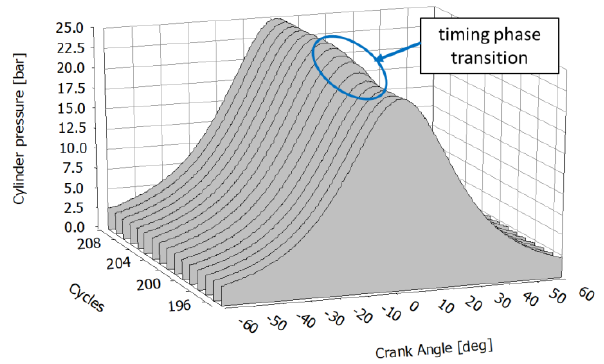
Fig. 20. Waterfall diagram showing the change in compression pressure during changes in the timing system adjustment